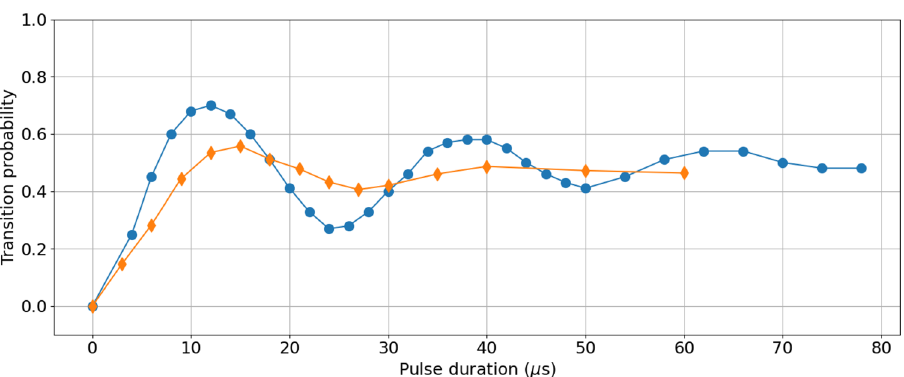
Figure 9. Transition probability versus pulse duration for Raman 2 transitions, performed when the atoms are going up (blue dots) and on their way down (orange